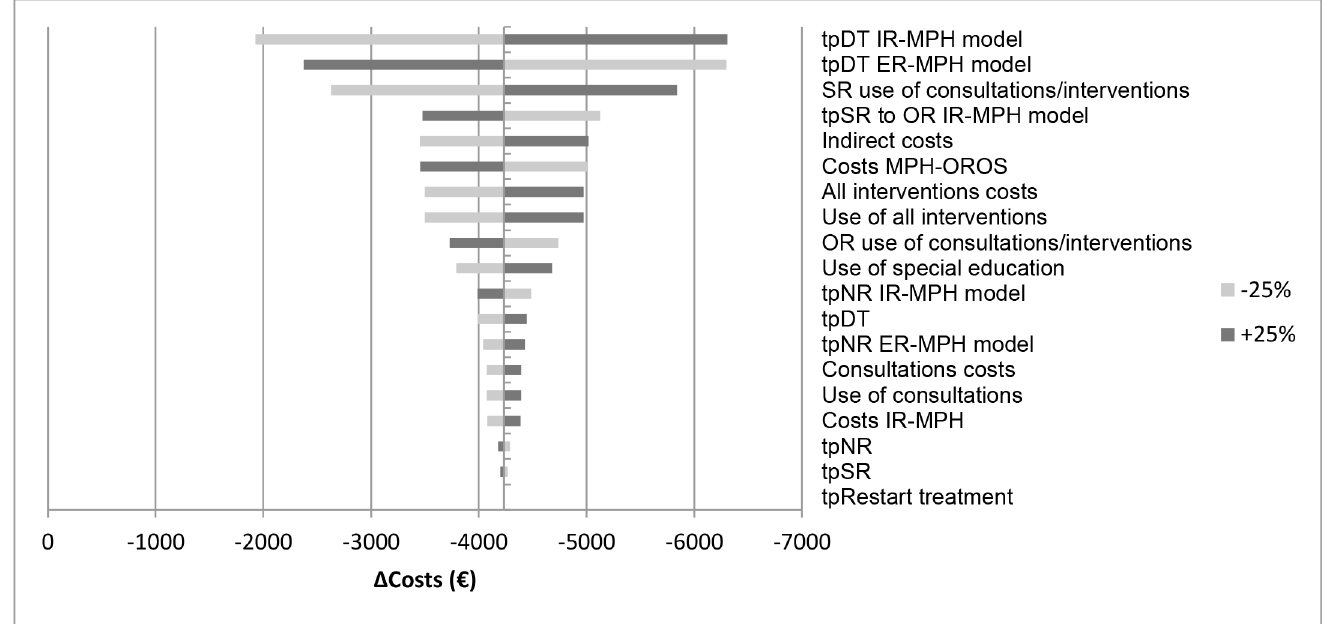
Fig 4. Effect of the univariate sensitivity analyses on the outcome of costs ( € ) (IR-MPH vs ER-MPH). Illustrative result for ER-MPH, example of MPH-OROS. tp = transition probability, SR = suboptimal response, OR = optimal response, DT = discontinuing treatment, NR = natural remission, IR-MPH = immediate release methylphenidate, ER-MPH = extended release methylphenidate.